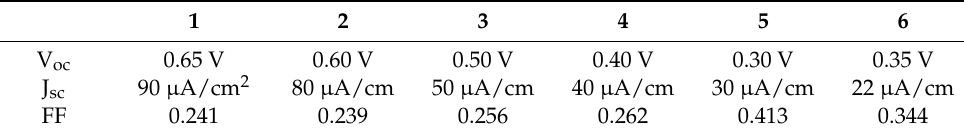
Figure 6. Performance of different thickeners in the dye layer (1:7 wt.% Simulgel with water; 2:8 wt.% xanthan gum with water; 3:12 wt.% ethyl cellulose with ethanol; 4:5 wt.% Stellmittel with ethanol; 5:5 wt.% Stellmittel with water; 6:20 wt.% Borchi gel with ethanol). Table 1. V oc , Jsc, and FF for Figure 6.